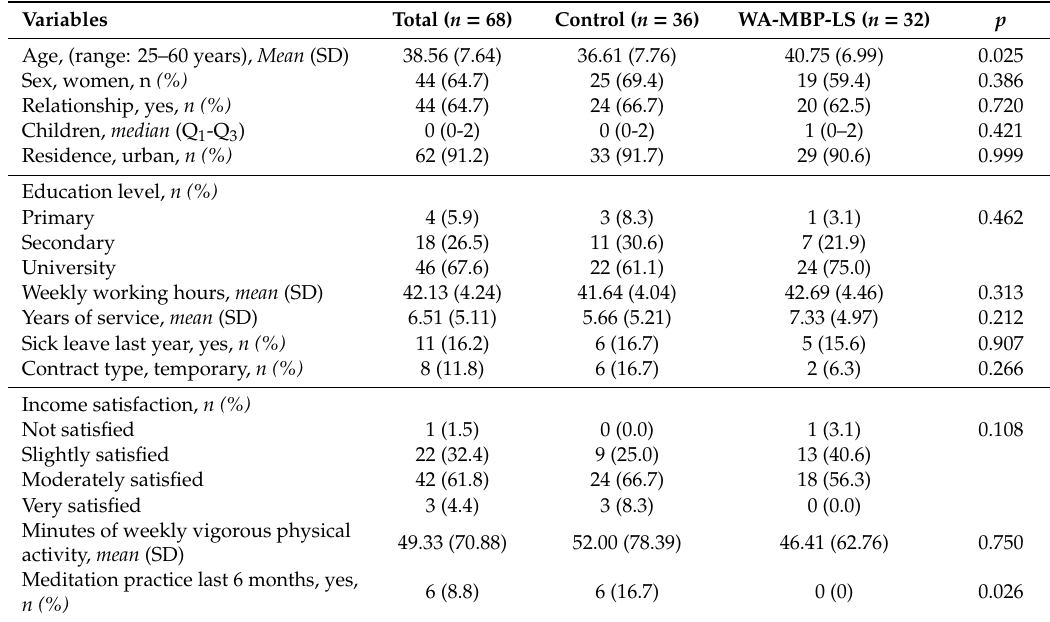
Table 2. Socio-demographic and labour data of participants at